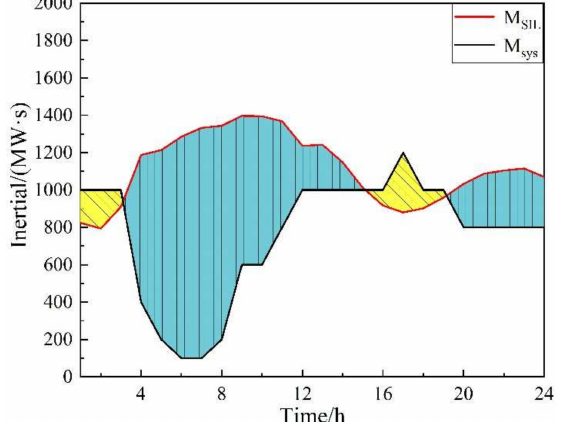
Figure 20. Typical daily inertia security region for scenario